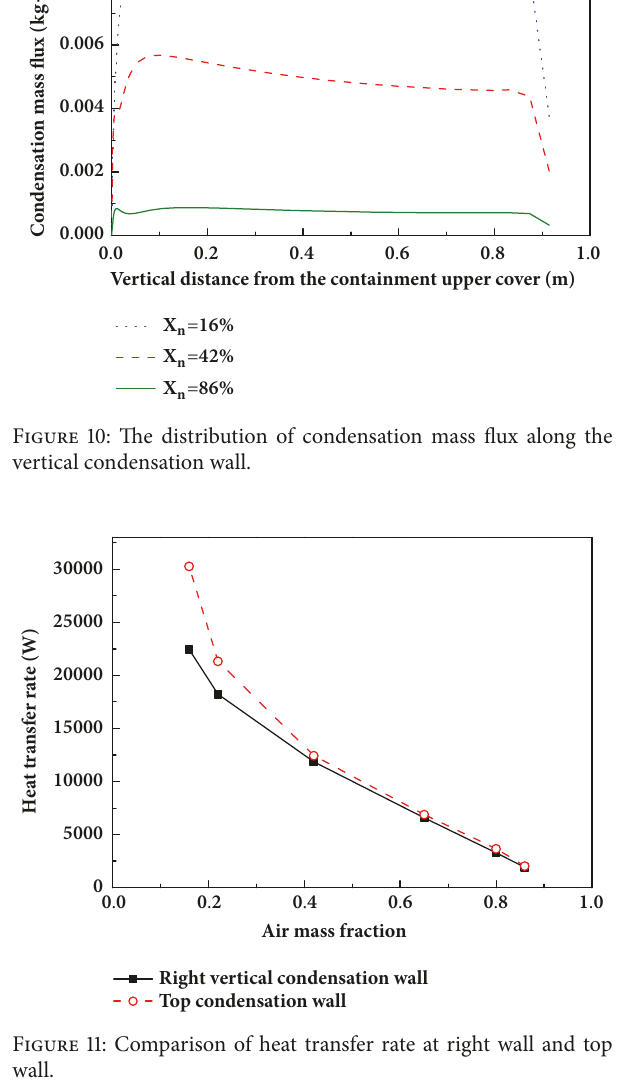
Figure 11: Comparison of heat transfer rate at right wall and top wall.